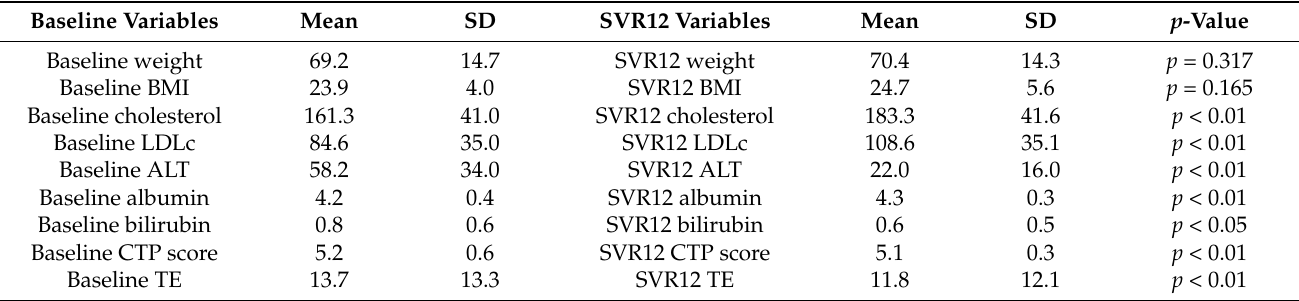
Table 3. before ‐ after laboratory value and anthropometric parameters *. Table 3. Before-after laboratory value and anthropometric parameters *.